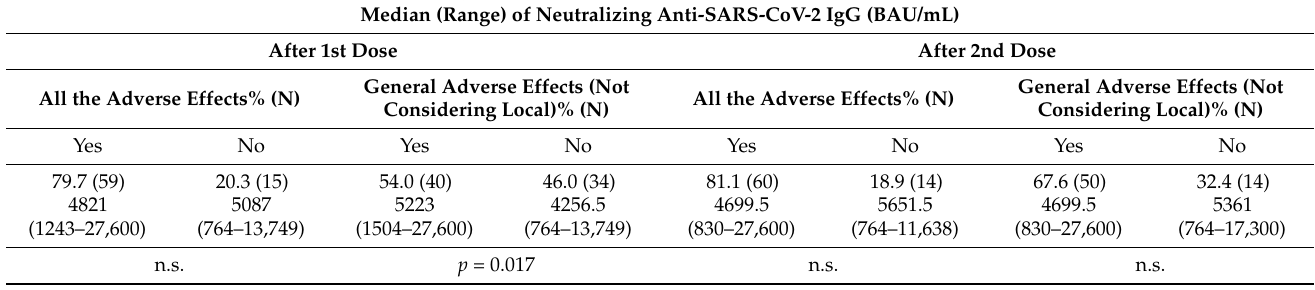
Table 4. Median levels of anti-SARS-CoV-2 neutralizing antibodies (IgG) in operators without and with adverse effects (all versus general effects, excluding local effects), after the first and the second dose of the BNT162b2 anti-SARS-CoV-2 vaccine. % (n) of Workers with/without the Adverse Effects & Median (Range) of Neutralizing Anti-SARS-CoV-2 IgG (BAU/mL) After 1st Dose After 2nd Dose All the Adverse Effects%